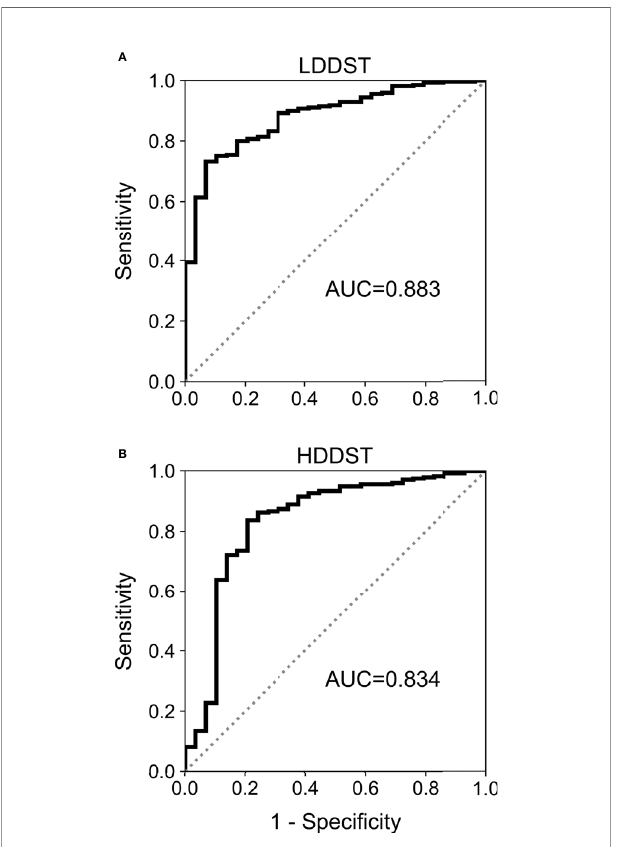
FIGURE 3 | Receiver operating characteristic (ROC) curves for (A) low-dose dexamethasone suppression test (LDDST) and (B) high-dose dexamethasone suppression test (HDDST) among all the included patients.